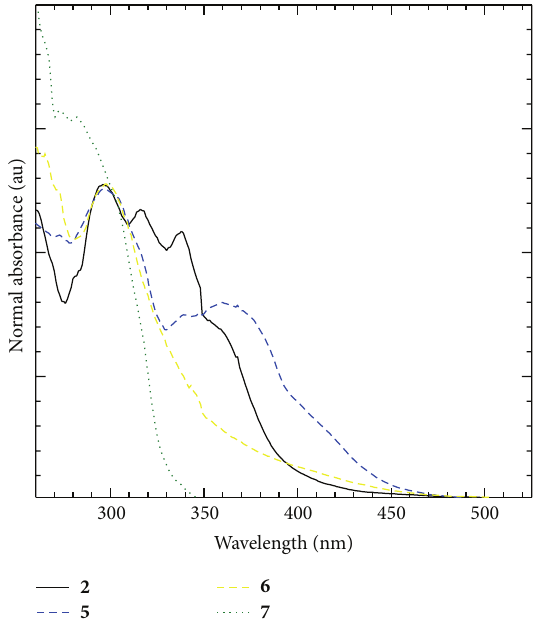
Figure 1: Normalized absorption spectra (at 300 nm) recorded on degassed 2-MTHF solutions of polymer subunit 2 and polymers 5 – 7